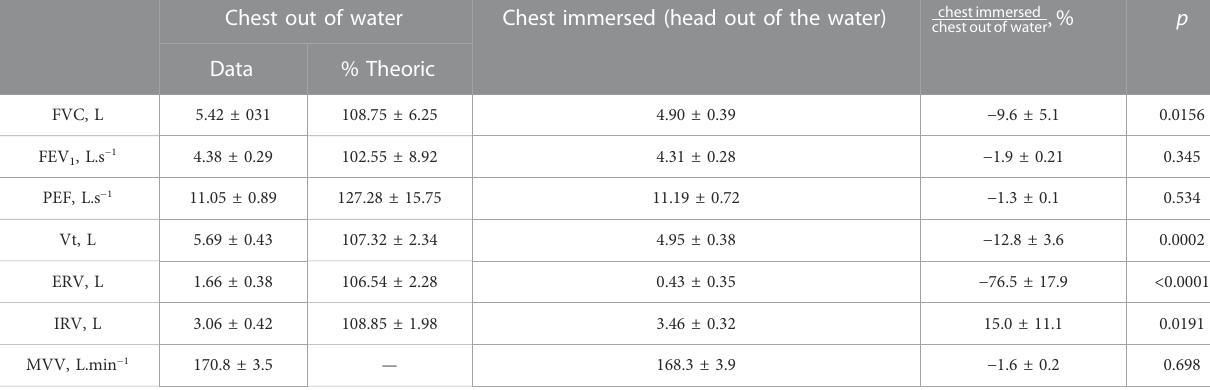
, % p chestoutofwater